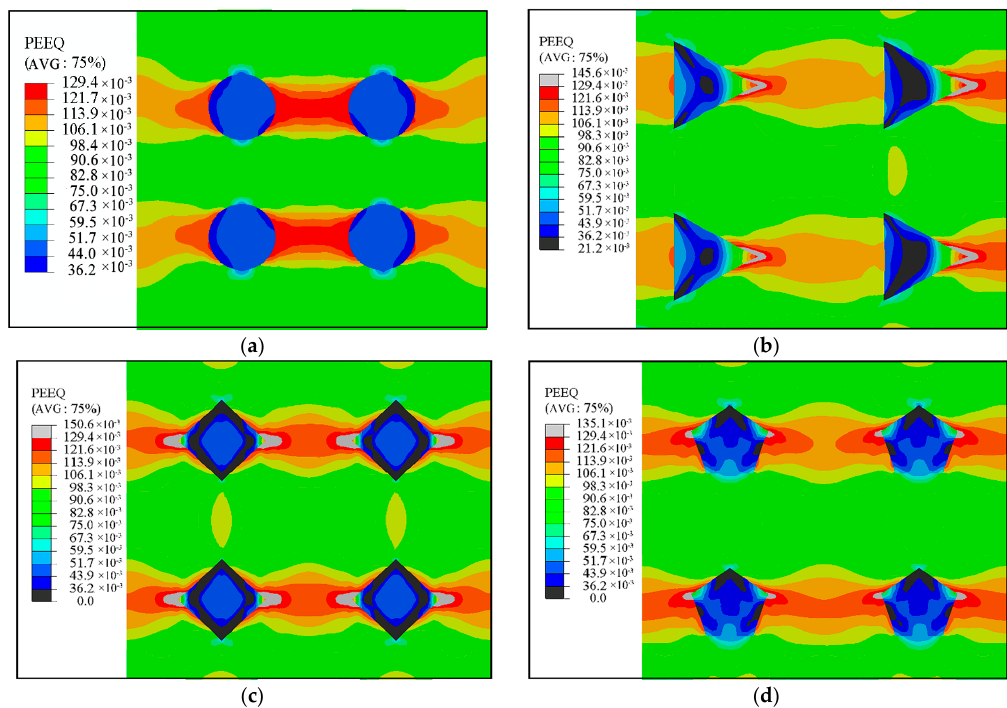
Figure 7. PEEQ distribution of the composite models with different SiCp shapes: ( a ) round particle doping; ( b ) equilateral triangle particle doping; ( c ) square particle doping; and ( d ) regular pentagon particle doping .